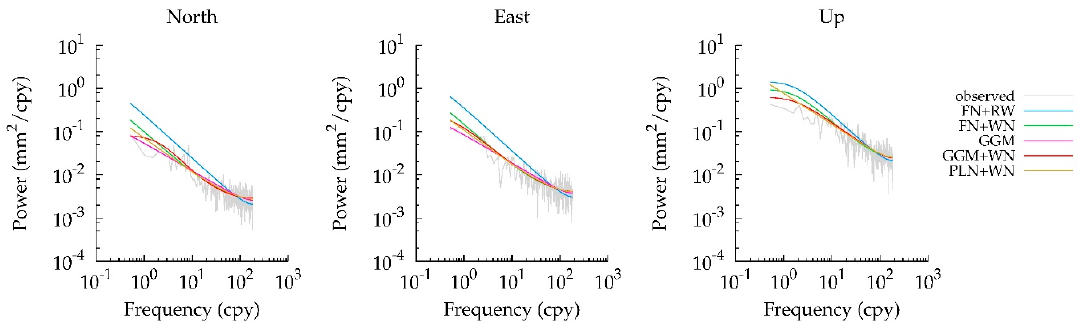
Figure 6. Power spectral densities of the time-series residuals of station MISS based on the solution BERN_2.